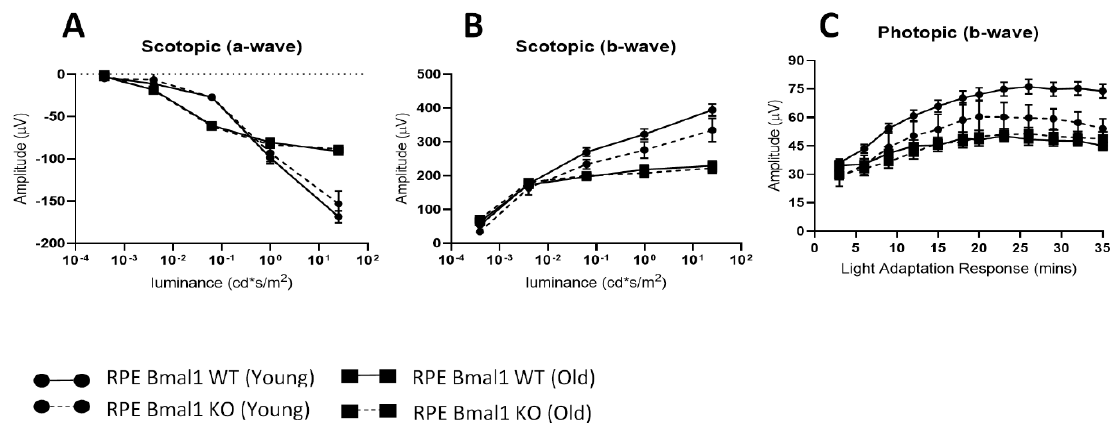
Figure 7. Functioning of rods and cones are not affected by the loss of Bmal1 in the RPE. Retina function was assessed with electroretinography at the level of both rod (i.e., scotopic) and cone (i.e., photopic) photoreceptors. At both ages examined, there was no difference in rod photoreceptor function in RPE Bmal1 KO when compared to RPE Bmal1 WT ( A , B ; p > 0.1, two-way ANOVA, n = 4 – 6/group). Additionally, cone photoreceptor function was also not affected in RPE Bmal1 KO when compared to RPE Bmal1 WT mice at all ages ( C ; p > 0.1, two-way ANOVA). Data are expressed as mean ± SEM.